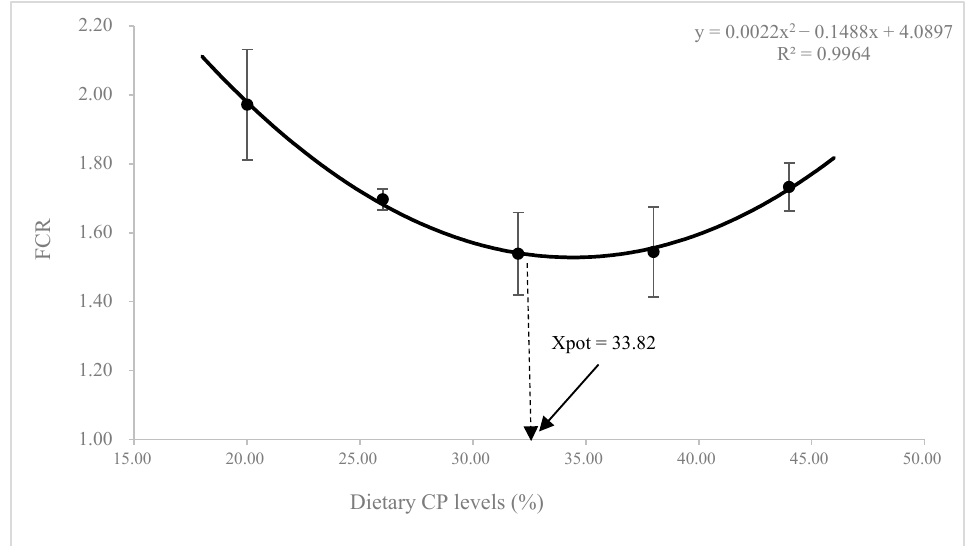
Figure 2. Relationship of feed conversion rate (FCR) with dietary CP levels of juvenile K. punctatus.